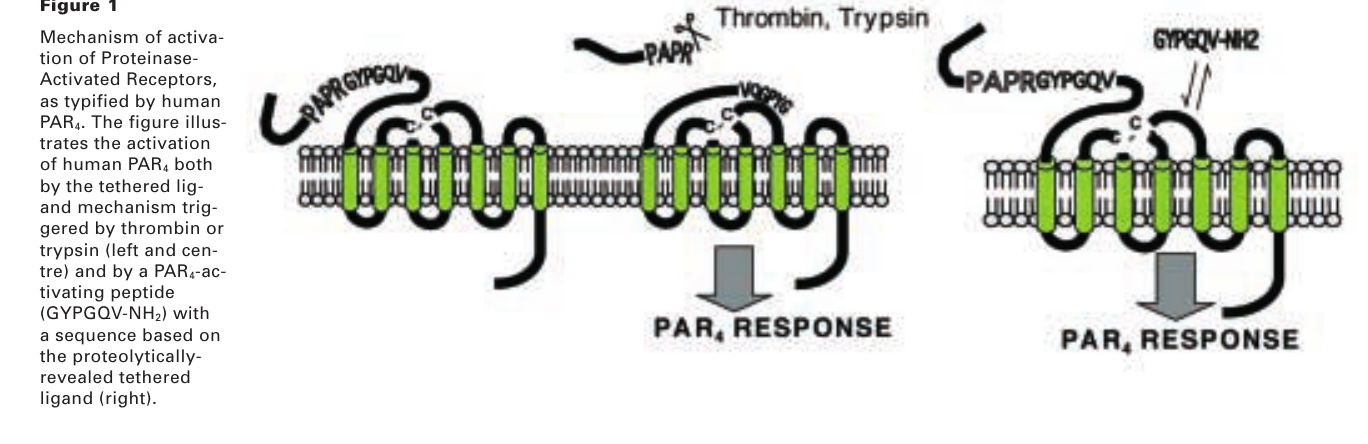
The PAR family of G-protein-coupled receptors. *